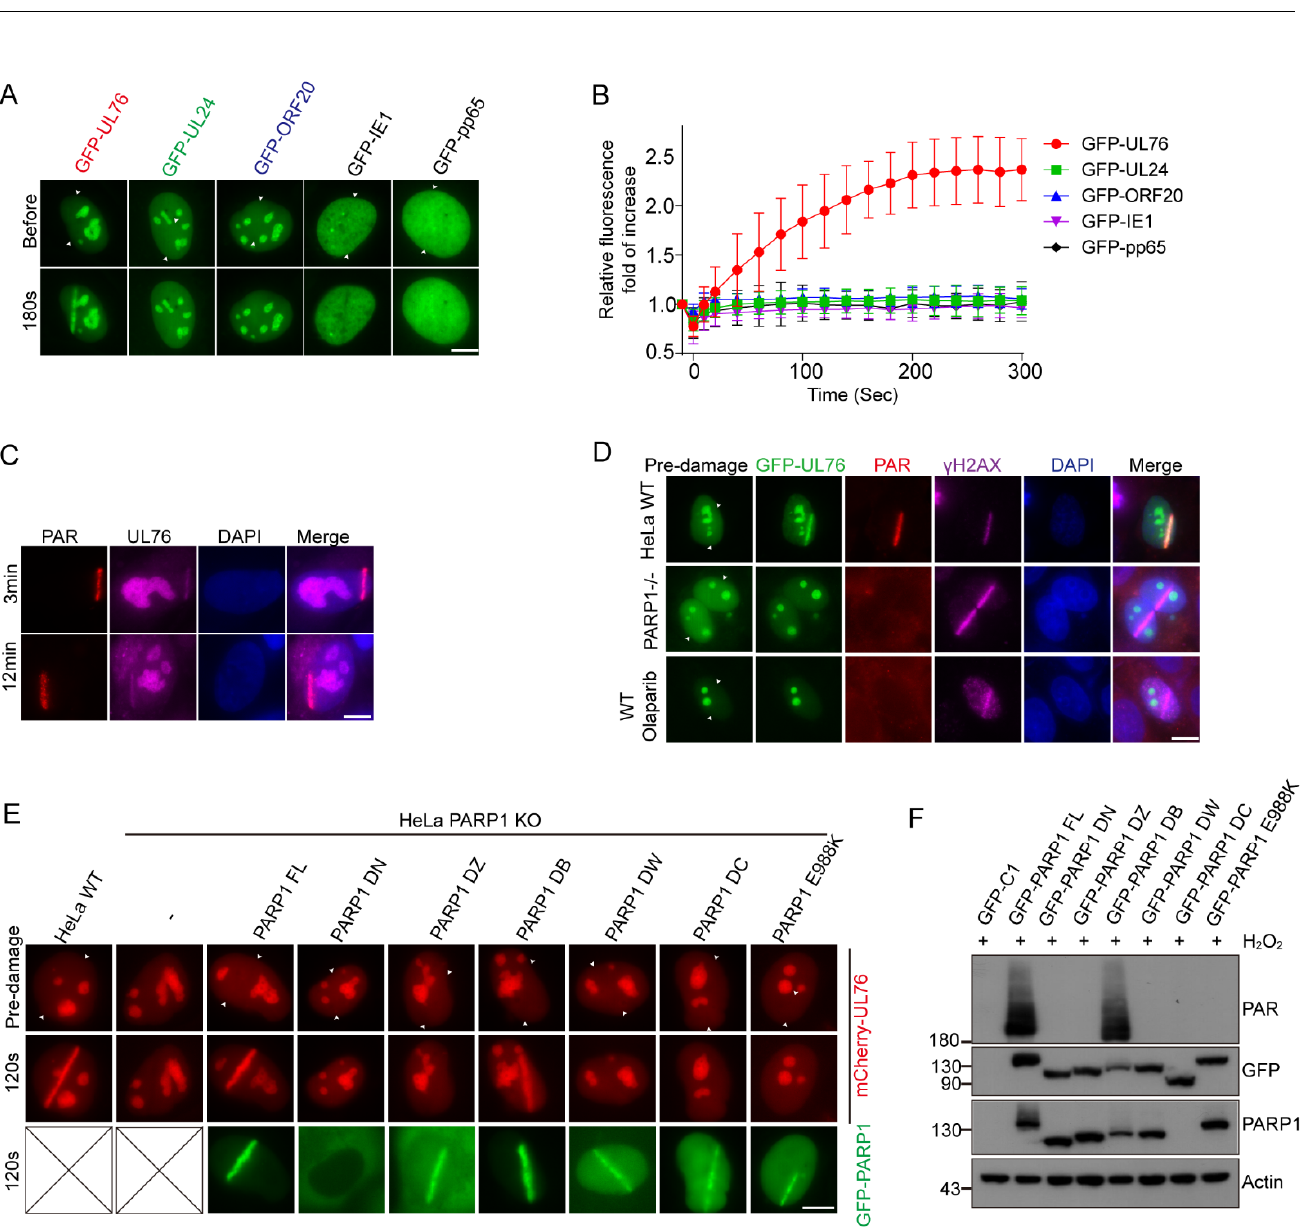
Figure 6. PAR-dependent recruitment of HCMV UL76 to DNA damage sites. ( A ) Several Herpesvirus genes were tested for their ability to accumulate at DNA lesions induced by laser micro-irradiation. Members of the Herpesvirus_UL24 family in HCMV (UL76), HSV-1 (UL24), KSHV (ORF20) and HCMV immediate early gene IE1, low matrix protein pp65 were transfected to U2OS cells with a GFP tag on their N terminus. Cells were subjected to laser irradiation, and live cell images were captured at indicated time points. Paired arrowheads indicated the orientation of the laser track. Scale bar, 10 µm. ( B ) Kinetics of the recruitment of UL76 and other tested proteins to DNA lesions were measured over 5 min post irradiation. The recruitment of these fluorescent proteins was quantified by the ratio of GFP intensity at the laser track normalized to GFP intensity at the same region pre-damage. The data are shown as mean ± SD, n = 14. ( C ) The recruitment of endogenous UL76 to DNA lesions in HCMV-infected cells. MRC-5 cells were infected with HCMV at an MOI of 1. Forty-eight hours post-infection, HCMV infected cells were selected for laser irradiation. Cells were then fixed and immunostained with indicated antibodies. Scale bar, 10 µm. ( D ) Recruitment of UL76 to DNA lesions depends on PAR synthesis. WT and PARP-1 KO HeLa cells were transfected with GFP-UL76 and subjected to micro-irradiation. Cells were fixed and stained with PAR and γ H2AX antibodies. In the Olaparib treatment panel, cells were pretreated with 10 µM Olaparib for 30 min before laser irradiation. Paired arrowheads indicated the orientation of the laser track. Scale bar, 10 µm. ( E ) PARP-1 knockout HeLa cells were co-transfected with mCherry-UL76 and GFP-PARP-1 full length or the indicated deletion mutant. Cells were subjected